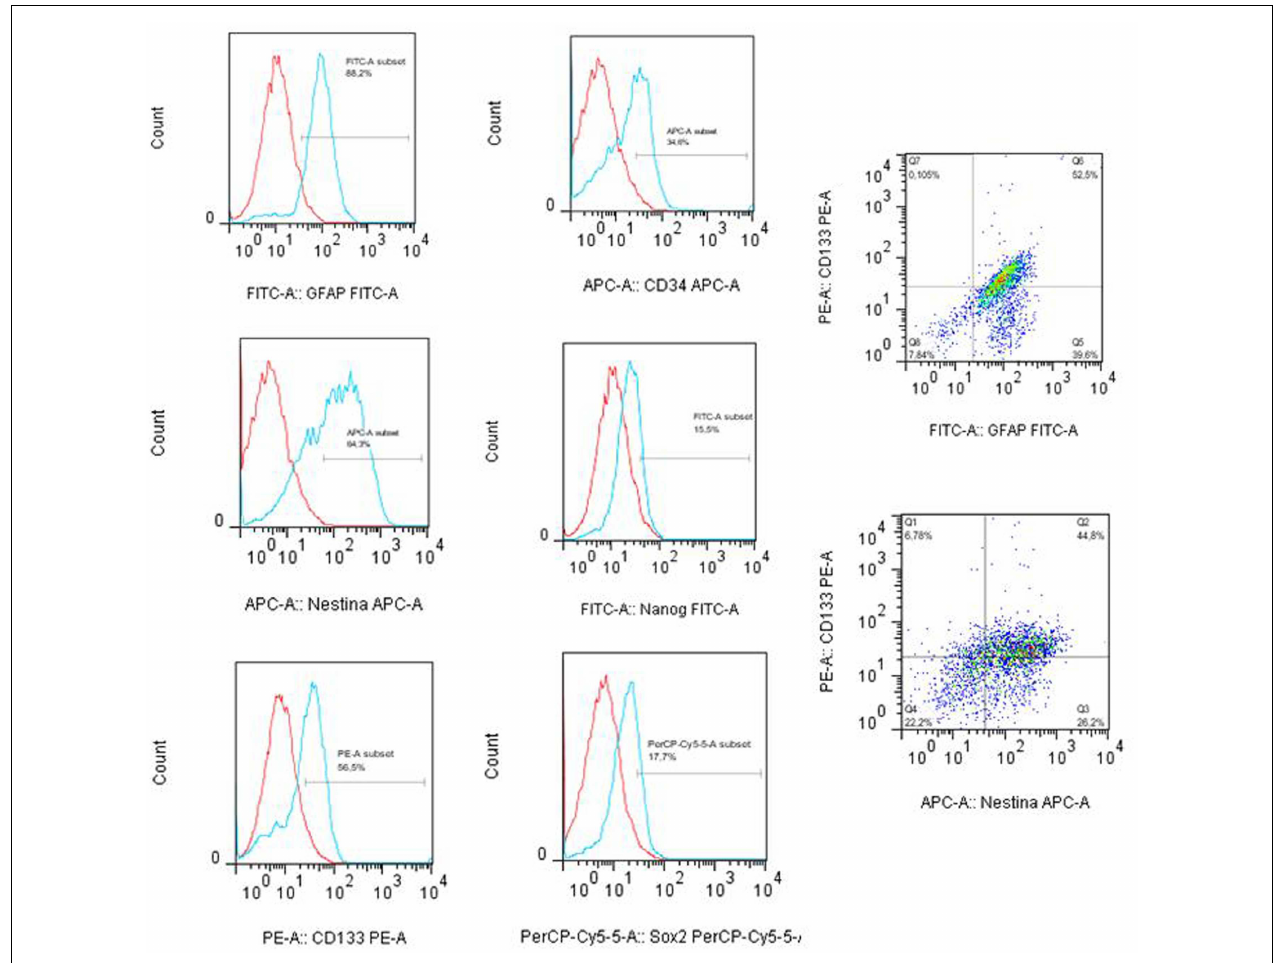
(64.2%), Sox2 (17.7%), CD34 (34.0%), and Nanog (15.5%) in glioblastoma subsphere samples and the co-expression of CD133 with GFAP (52.5%) and Nestin (44.8%). Representative figure of five samples of